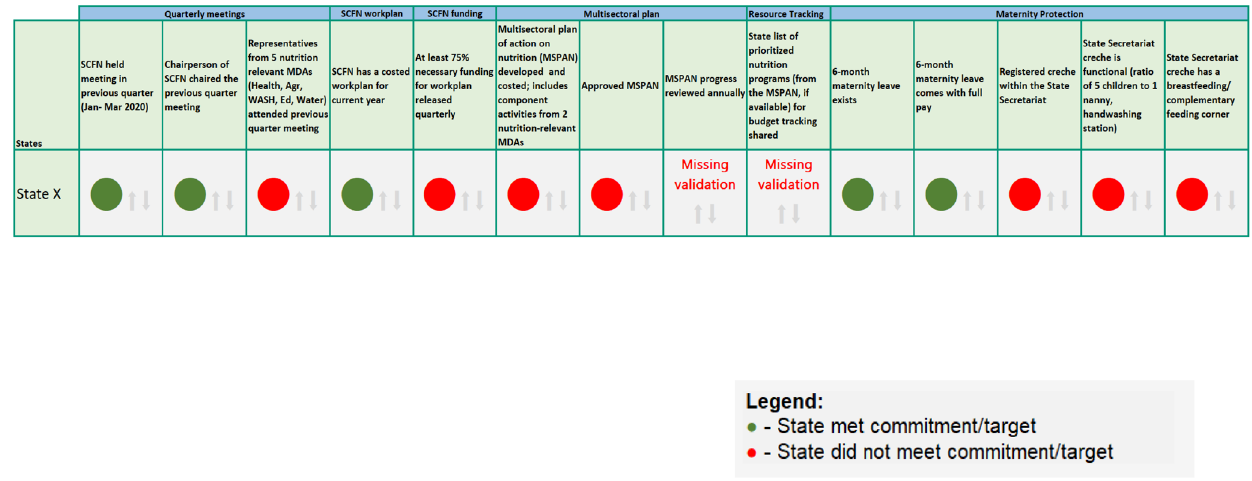
Figure 5. Full scorecard for State Committee on Food and Nutrition (SCFN)internal tracking purposes. Green=State met commitment/target; Red=State did not meet